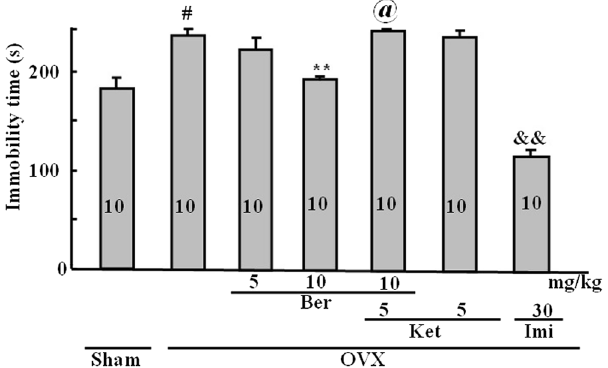
Figure 3. Duration of immobility time (s) in the forced swim test. Group conditions are indicated by abbreviations, and doses by numbers: Sham (sham treatment), OVX (ovariectomy), Ber (berberine, 5 or 10 mg/kg), Ket (ketanserin, 5 mg/kg) and Imi (imipramine, 30 mg/kg). Symbols represent significant post hoc comparisons: Tukey’s HSD, # P < 0.05 vs. sham, ** P < 0.05 vs. OVX, @ P < 0.05 vs. OVX + Ber 10 mg/kg, && P < 0.01 vs. OVX.